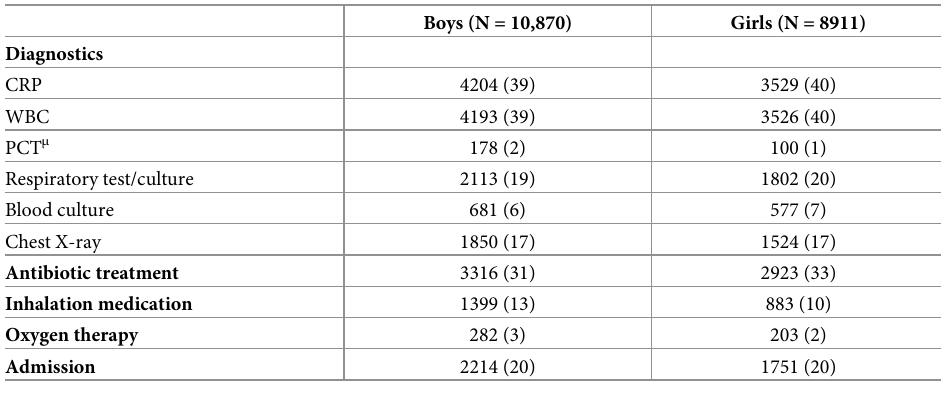
Table 2. Management stratified by sex (N = 19,781).